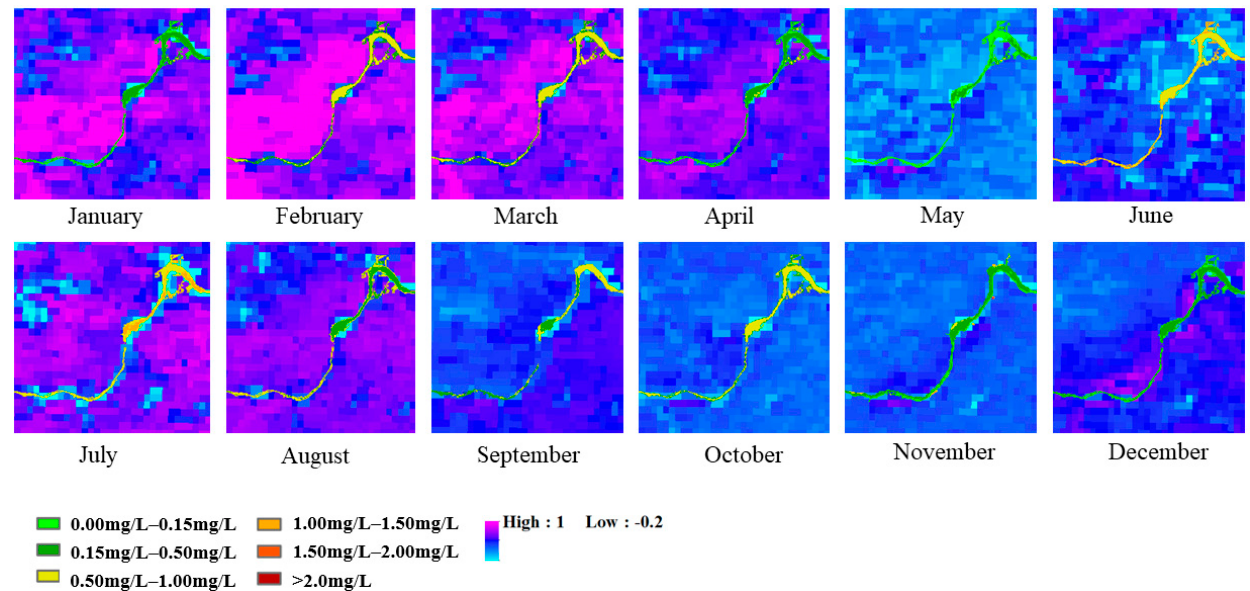
Figure 12. Region (b) monthly NH 3 -N concentration and NDVI changes.